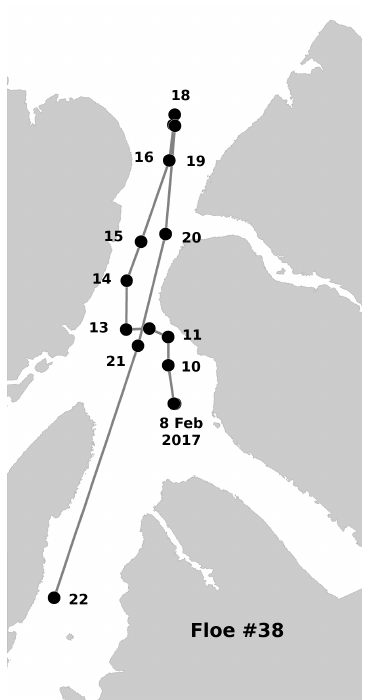
Figure 13. Trajectory of an ice floe (floe no. 38) that separated from landfast ice and drifted in the polynya regime downstream of the ice arc. The track is shown from 8 to 22 February